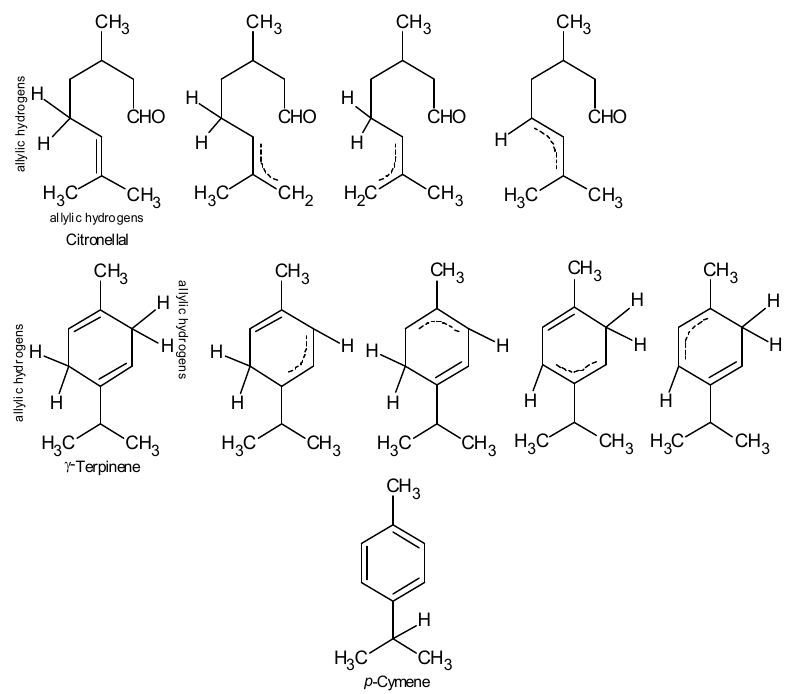
Figure 1. Chemical structure of citronellal, γ-terpinene and p -cymene. Citronellal and γ-terpinene representing the allylic hydrogens. The radical formed can be stabilized by resonance.